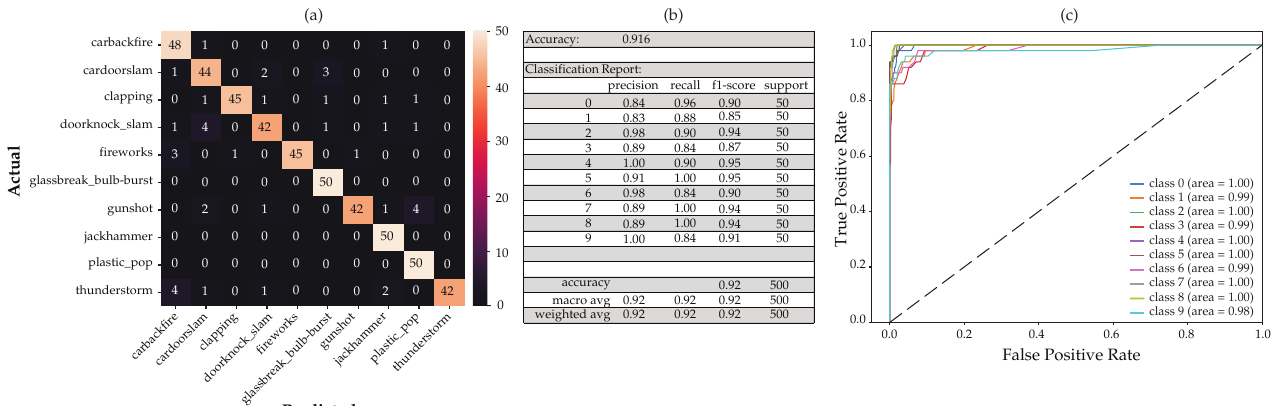
Figure 13. Full feature analysis showing the ( a ) confusion matrix, ( b ) classification report and, ( c ) ROC